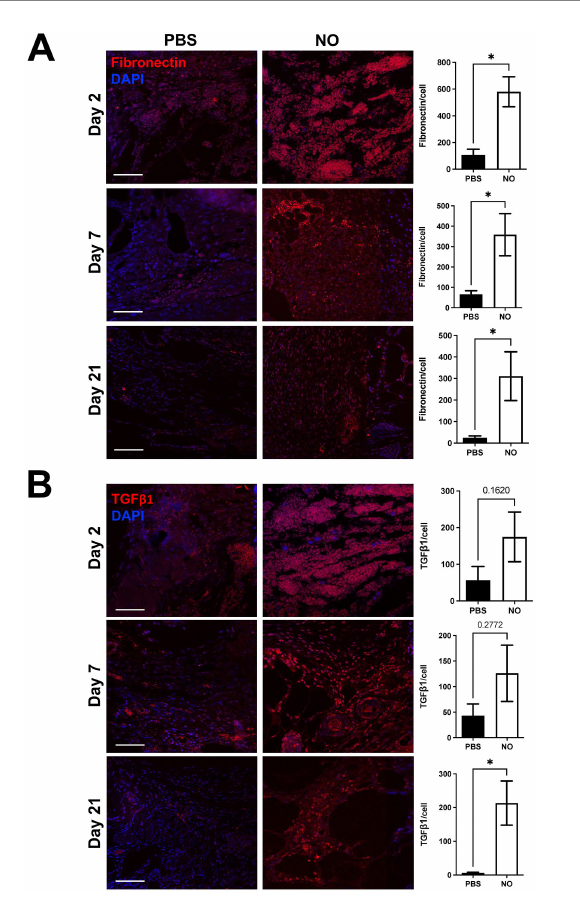
FIGURE 4 (A) Immunostaining for Fibronectin and (B) TGF- β 1 in tissue sections on days 2, 7, and 21 (healed). Scale bars: 50 μ m. Quantification of percent area positive for marker in each section. Data are presented as mean value ± SEM, * p <